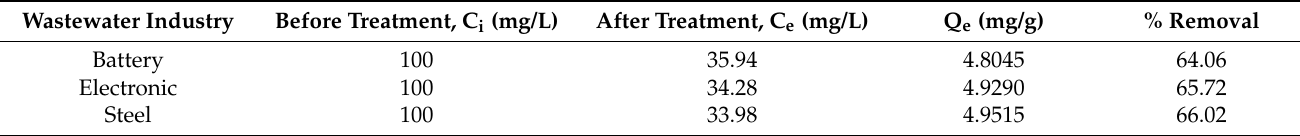
Table 4. Analysis of the real wastewater samples before and after